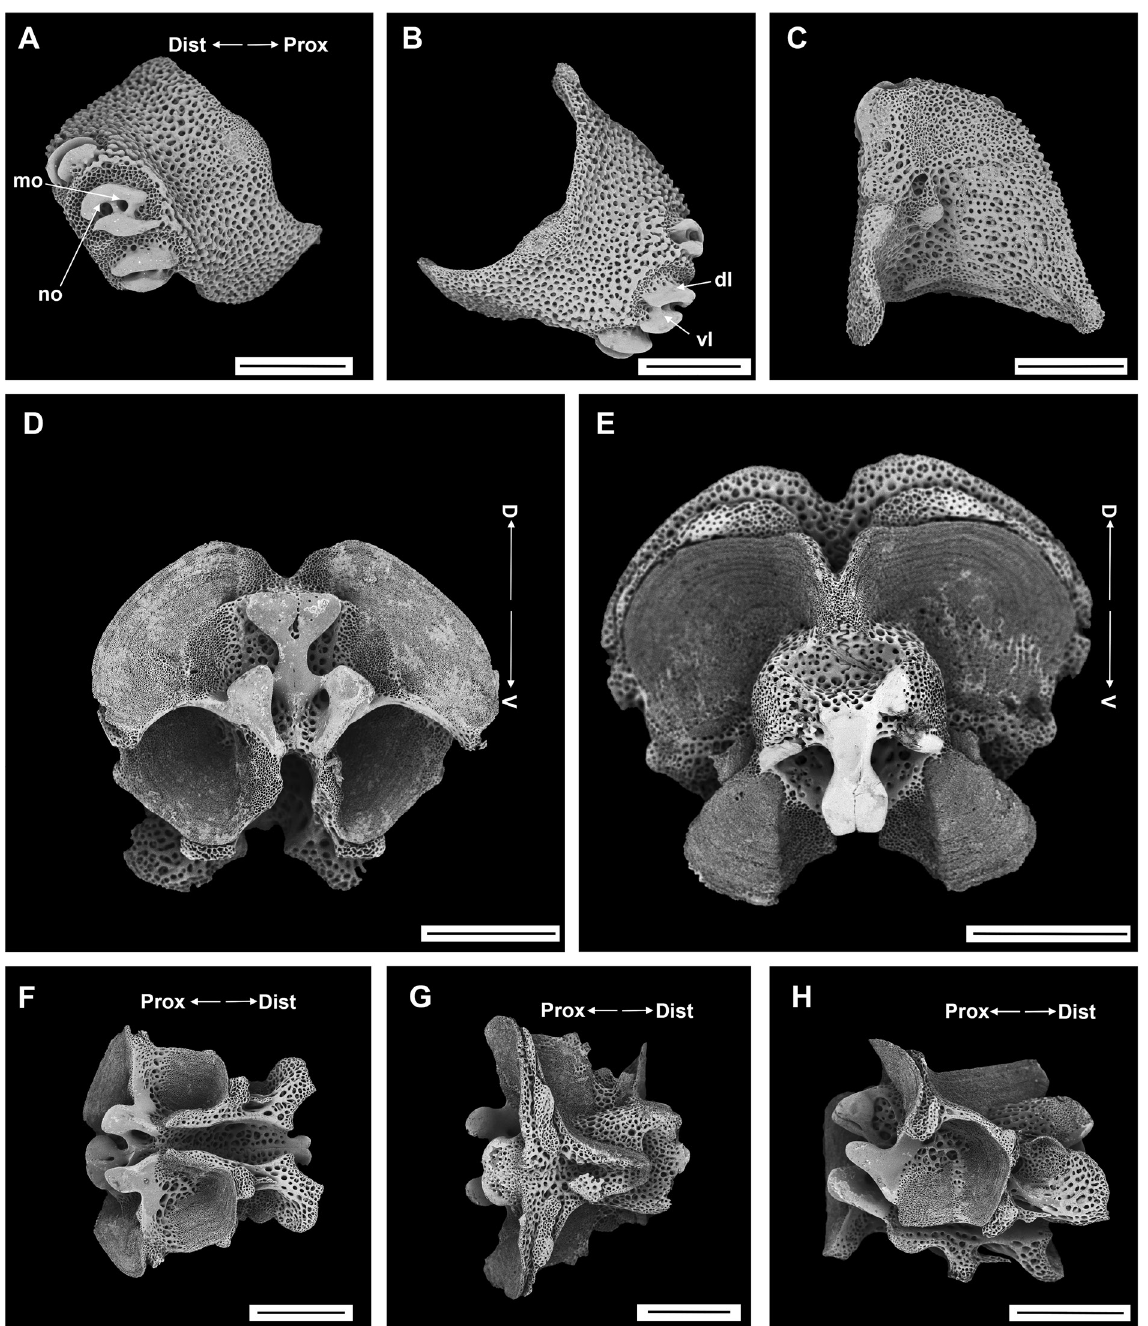
Fig. 41. Ophiactis cf. brachygenys H.L. Clark, 1911, SEM (IDSSE EEB-SW0015 = heptamerous specimen). A–C . Lateral arm plate (internal, external). D–H . Vertebrae. D . Proximal view. E . Distal view. F . Ventral view. G . Dorsal view. H . Lateral view. Abbreviations: D = dorsal; Dist = distal; dl = dorsal lobe; mo = muscle opening; no = nerve opening; Prox = proximal; V = ventral; vl = ventral lobe. Scale bars = 300